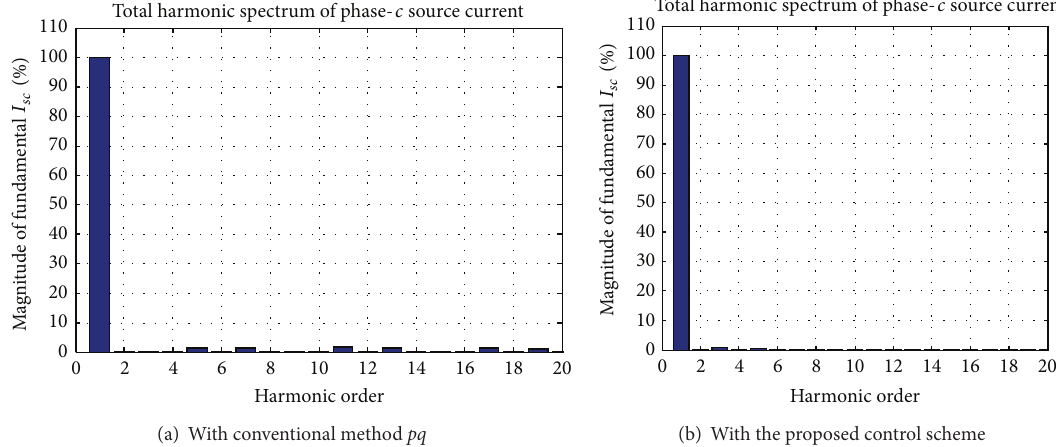
Figure 21: Frequency spectrum of phase- c source